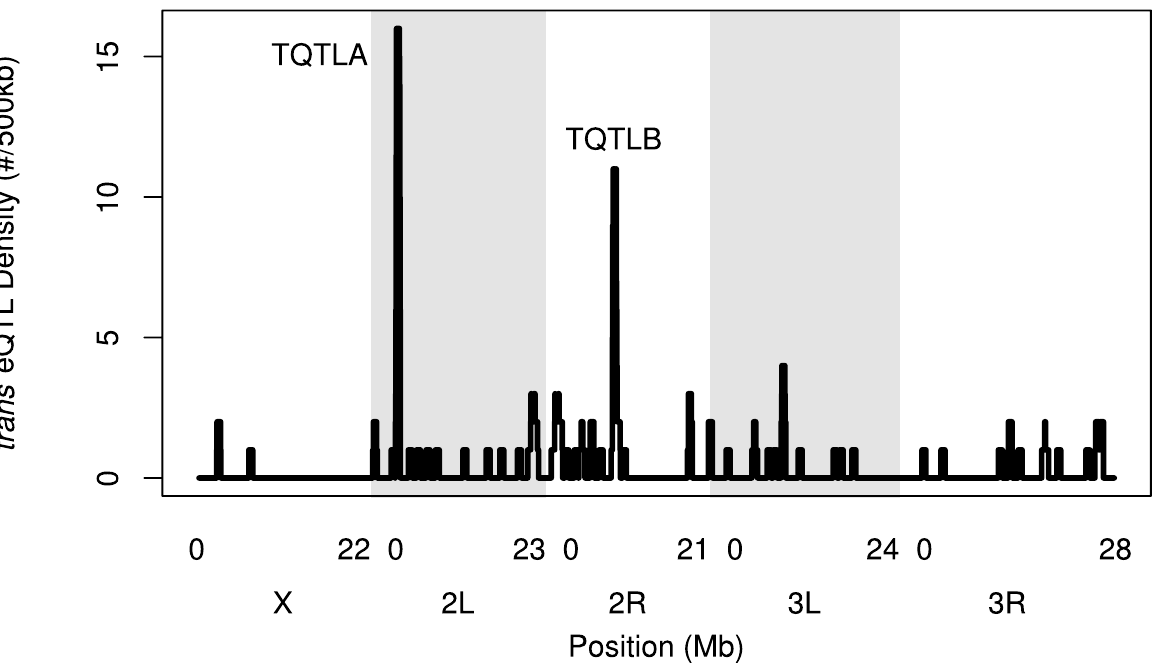
Figure 4. The density of trans -eQTLs along the genome. Density is the number of genes (not transcripts) with a trans -eQTL per 500 kilobases. Grey and white shading denote the different chromosome arms. Potential hotspots (regions with a density greater than 5) are noted.